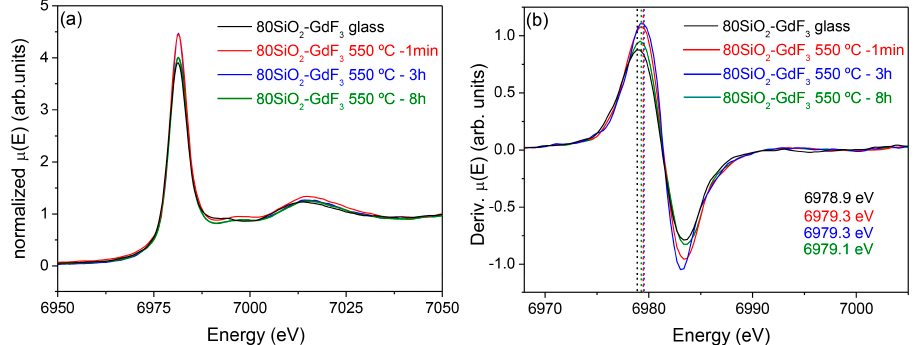
Figure 20. XAS ( a ) spectra and ( b ) derivate of 0.5Eu 3+ -doped 80SiO 2 -20LaF 3 xerogel and GC samples treated at 550 °C for 1 min up to 8 h. The values shown in ( b ) refer to the maximum of the derivate curves. Materials 2018 , 11 , x FOR PEER REVIEW